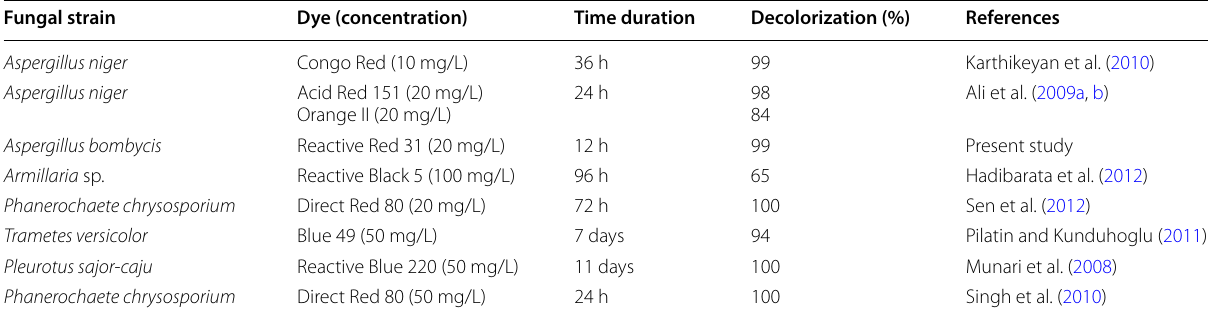
Table 1 Comparative performance of selected Aspergillus bombycis culture with other fungal strains for dye removal from aqueous solutions